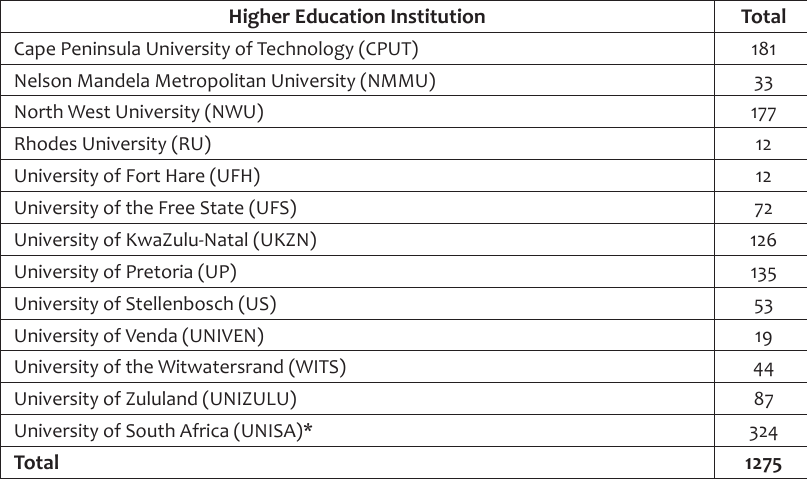
Table 1: Numbers of new foundation phase teachers that were expected to graduate from 13 public HEIs at the end of